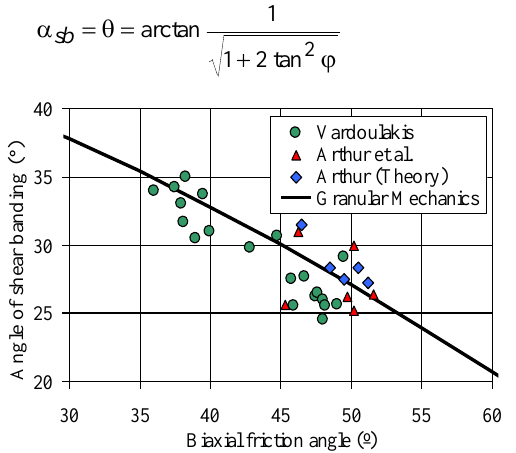
Fig. 5. Relationship between the friction angle and the inclination of shear banding in a biaxial compression test. Data compiled by